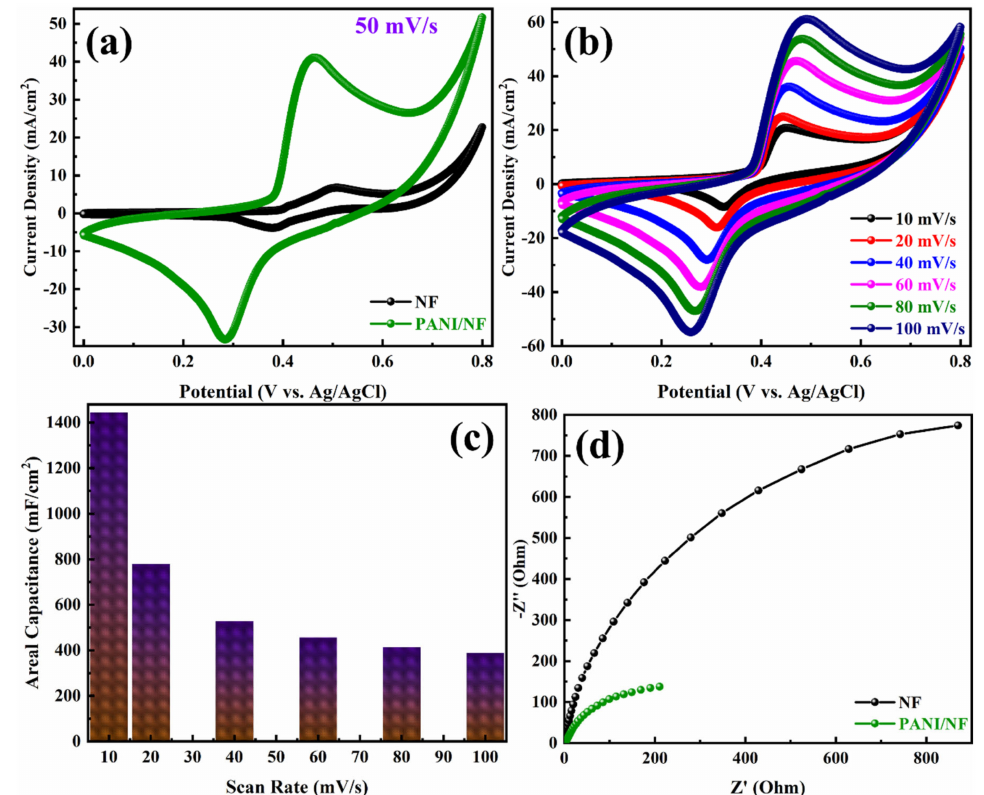
Figure 7. Cyclic voltammograms of ( a ) bare NF and PANI/NF at a scan rate of 50 mV/s, ( b ) PANI/NF at different scan rates. ( c ) Areal capacitance of the PANI/NF electrode as a function of the scan rate and ( d ) Nyquist plots of bare NF and PANI/NF in the three-electrode